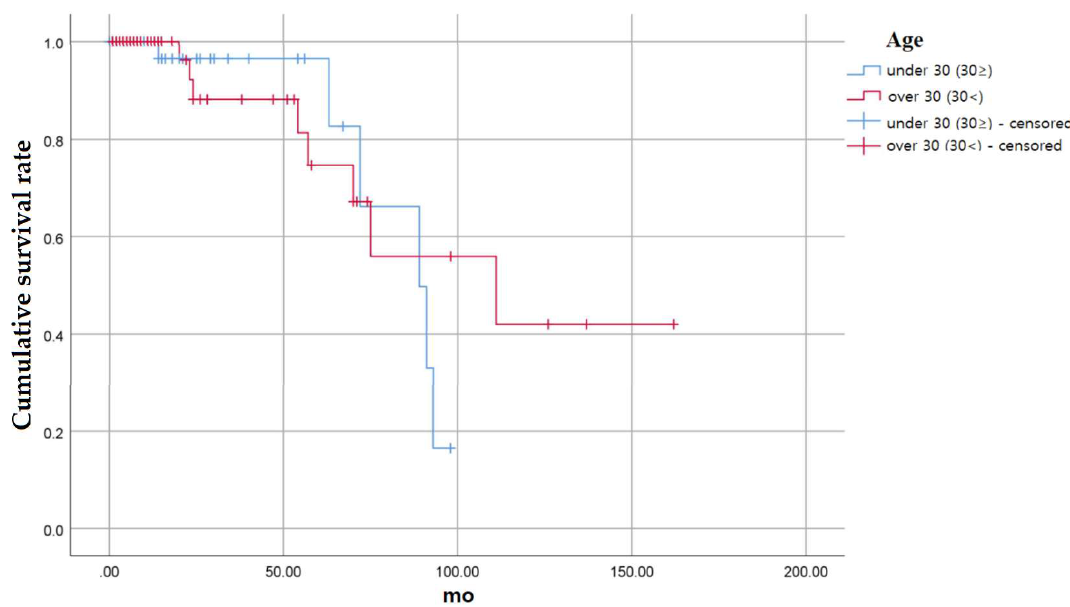
Figure 5. Cumulative survival rate of auto-transplanted tooth according to the age of patients.